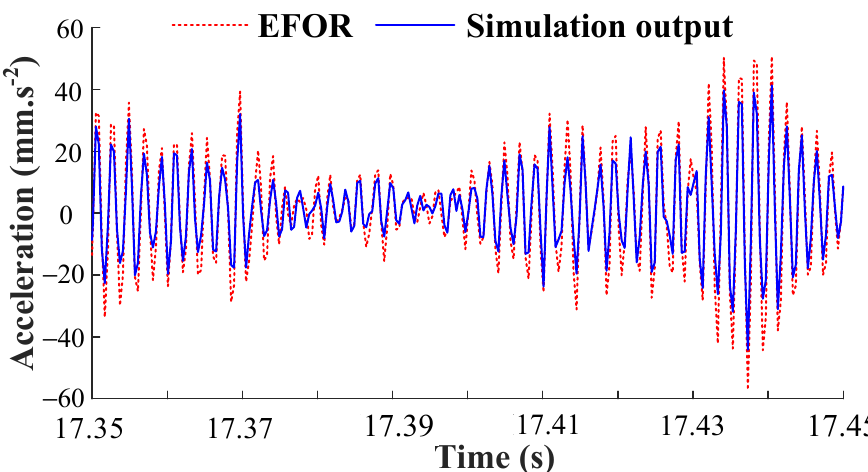
The EFOR output of δ = 10 Nm predicted by the Models (29) and (30) are compared with the simulation results, as shown in Figure 9.